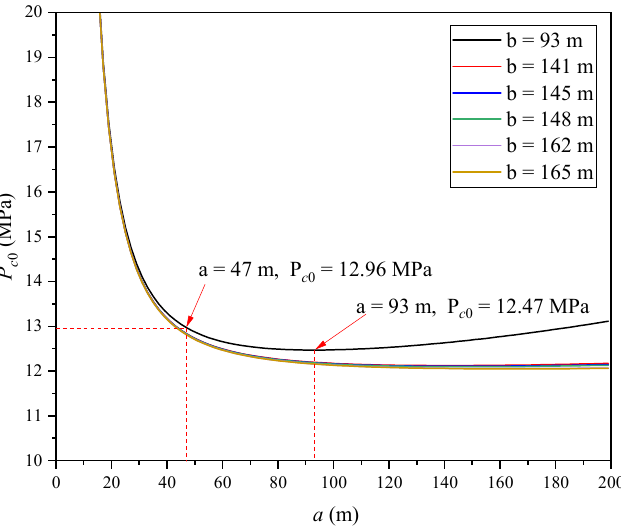
Figure 5. Relationship between critical water pressure ( P c 0 ) and length of the unloading zone ( a ) (when h 0 = 15.8 m, the parameters are shown in Table 2).